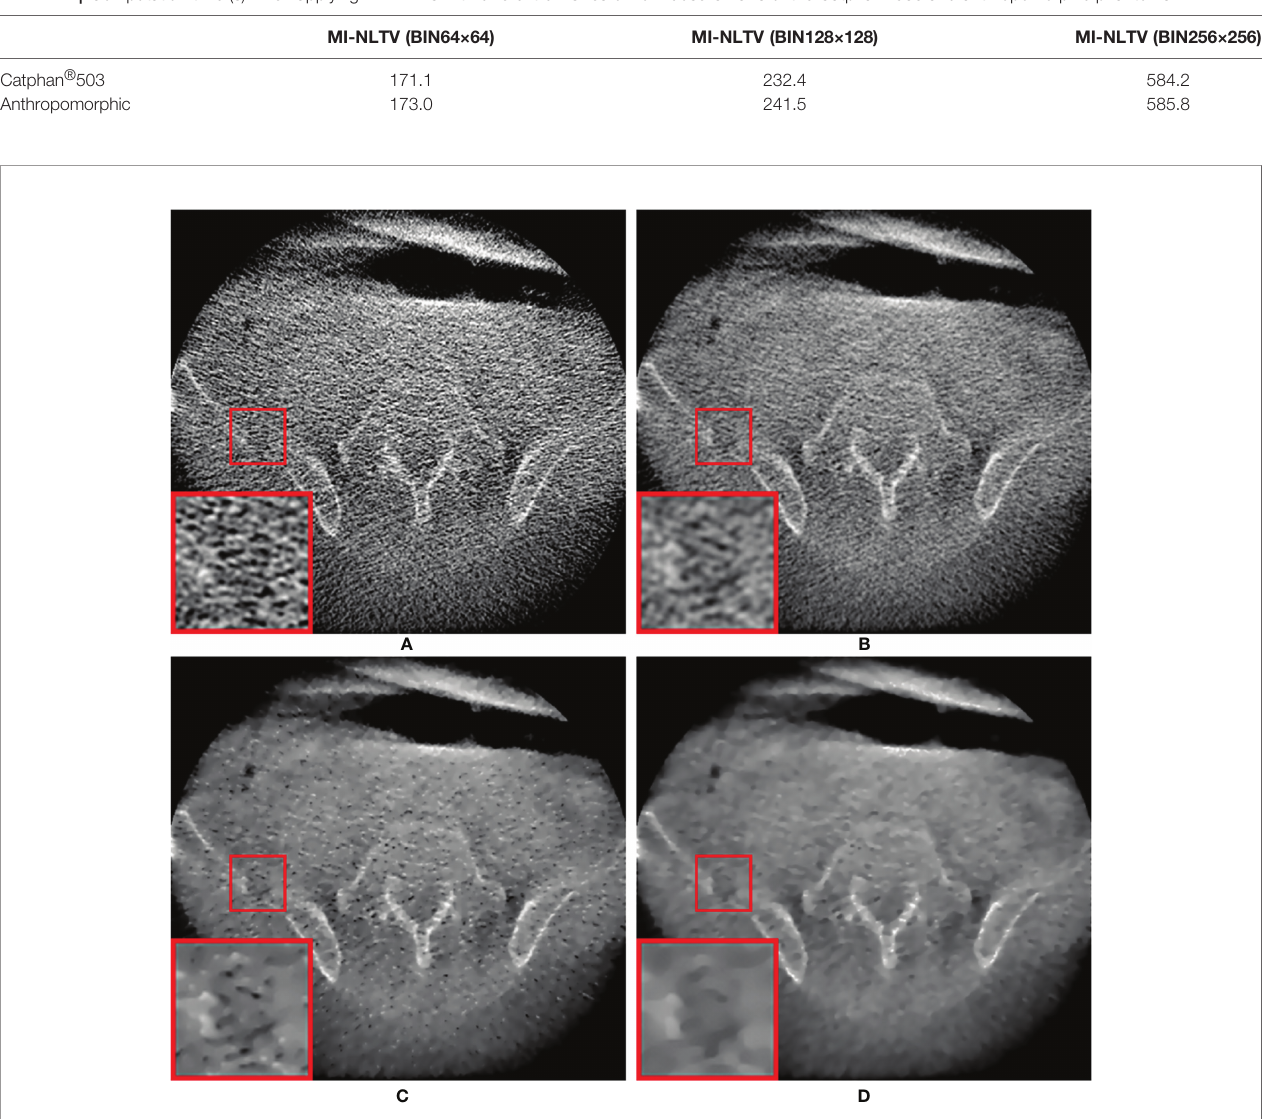
TABLE 7 | Computation time (s) when applying MI-NLTVs with different bin sizes on low-dose CBCTs of the Catphan ® 503 and anthropomorphic phantoms.